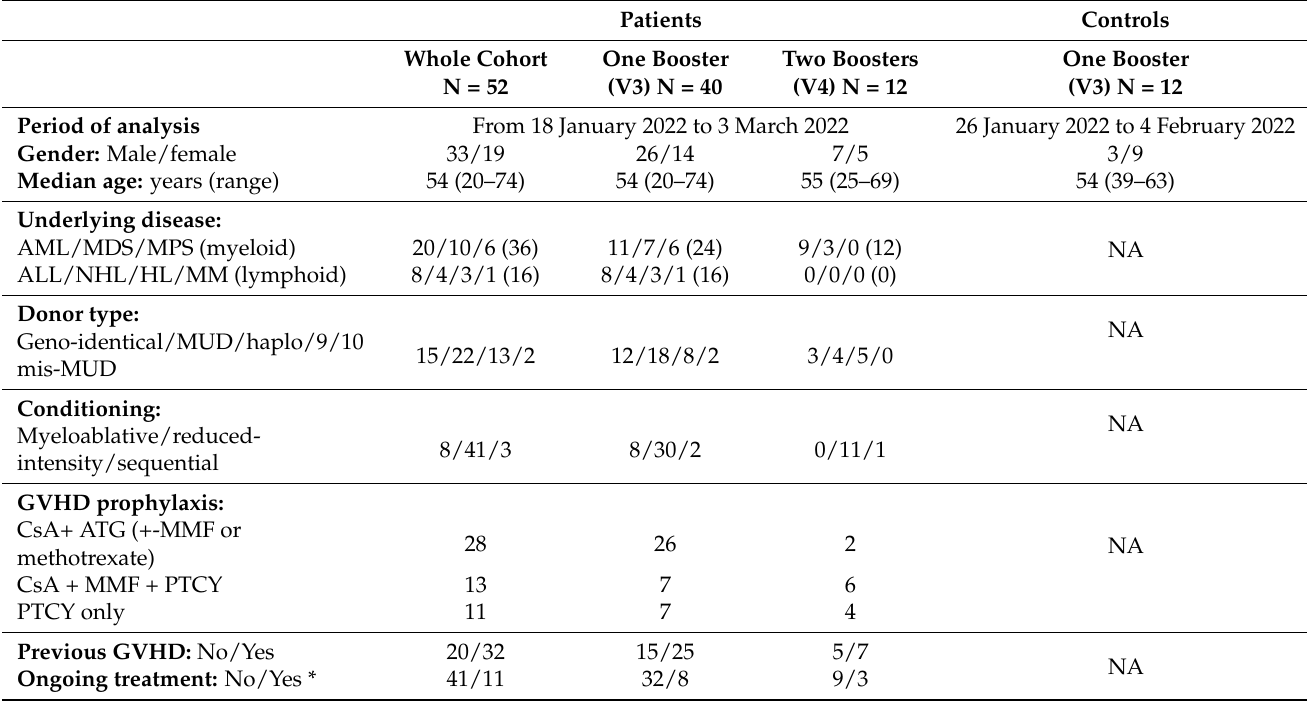
Table 1. Patient and control